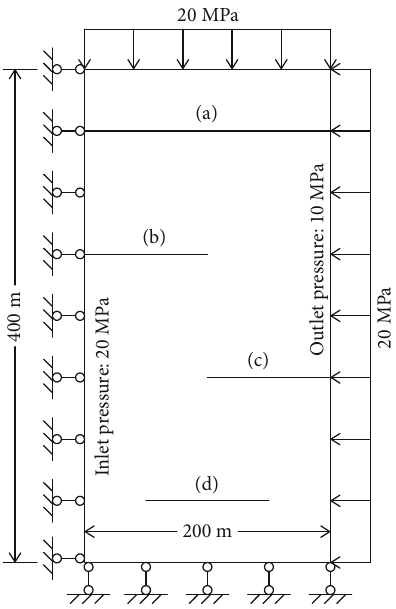
Figure 5: Fracture distribution diagram between two horizontal